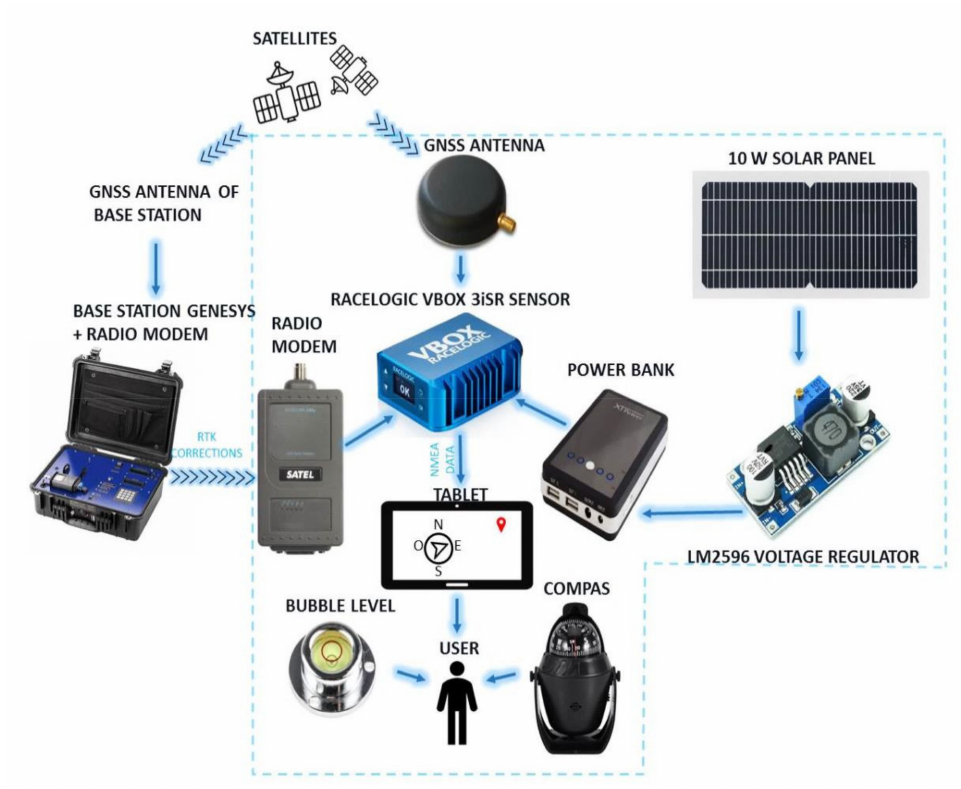
Figure 6. Graphical scheme of the stake-out geolocation device integrated the solar charging system (highlighted into the dashed